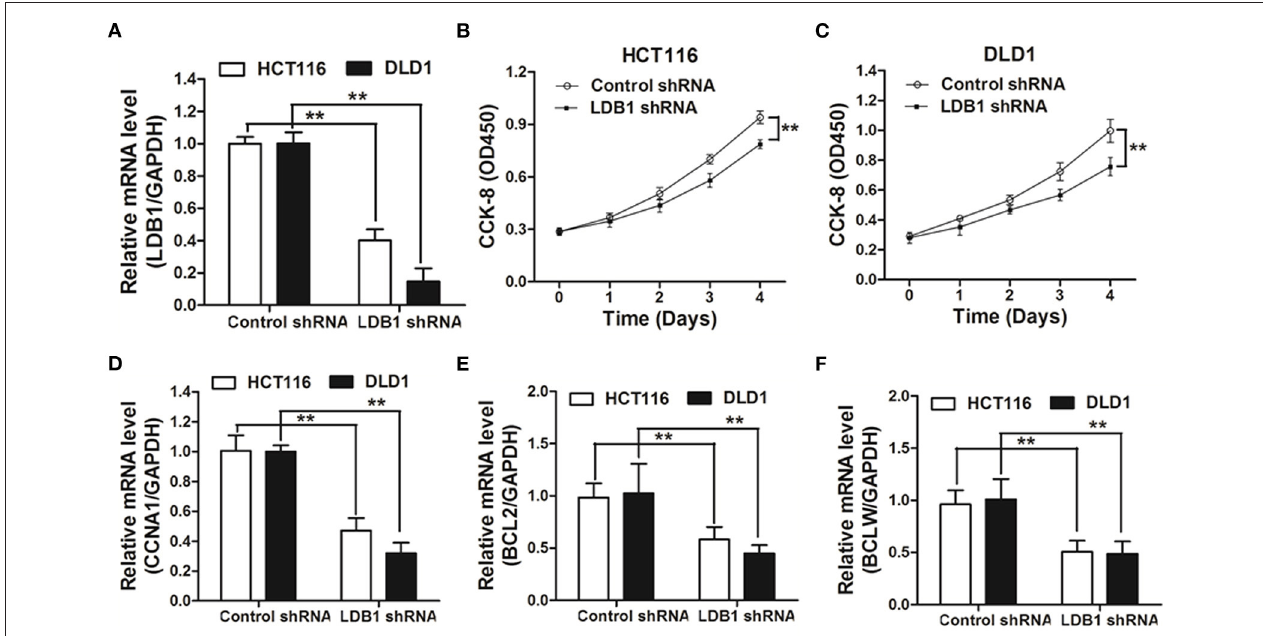
FIGURE 3 | Knockdown of LDB1 inhibits cell proliferation in colorectal cancer. (A) The silencing effects of LDB1 shRNA in HCT116 and DLD1 cells were analyzed by qRT-PCR. (B,C) HCT116 (B) and DLD1 (C) cells infected with control or LDB1 shRNA-derived lentivirus were cultured for 0, 1, 2, 3 or 4 days, followed by CCK-8